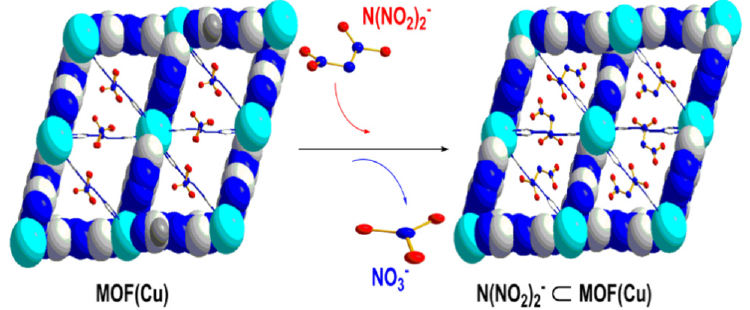
Figure 8. Encapsulating [N(NO 2 ) 2 − ] ion within the 3D EMOFs by ion-change process [80].